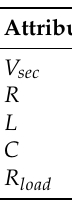
Table 2. Transmission line example